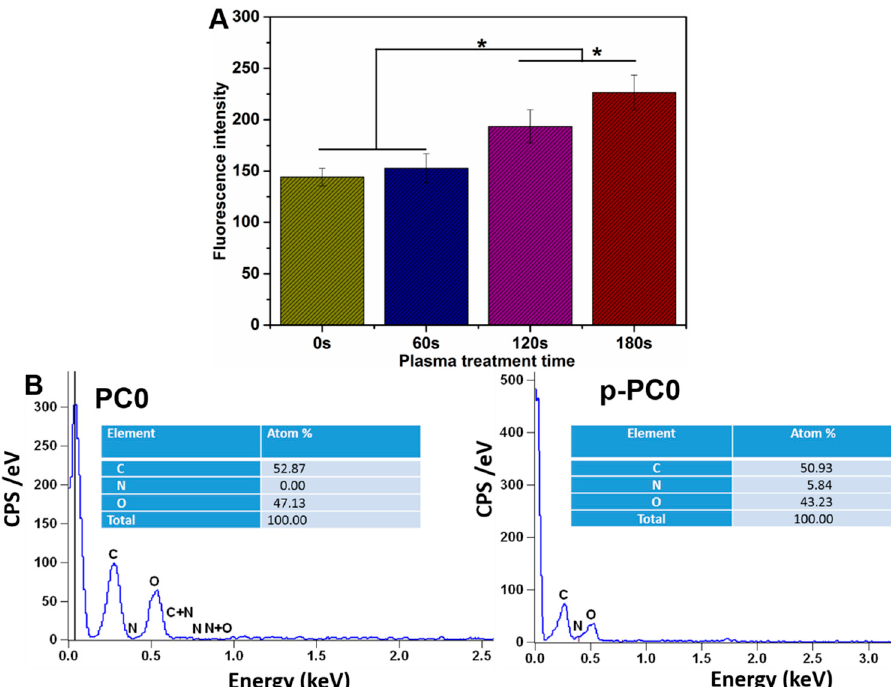
Figure 6. ( A ) The adhesion of PC12 cells on PC0 nanofibers with different plasma treatment times; ( B ) EDX spectra and atomic ratios (%) of PC0 nanofibers before and after plasma treatment of 180 s.